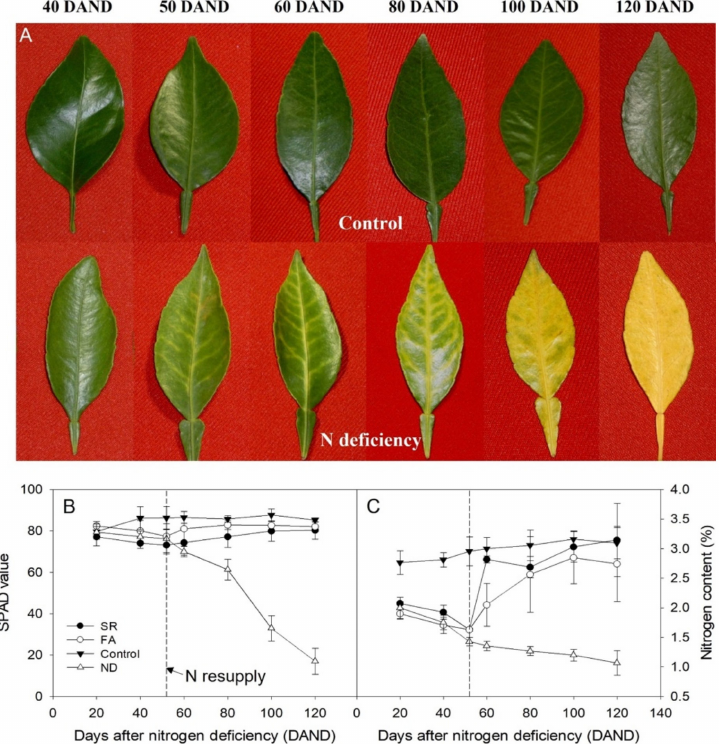
Figure 1. ( A ) Leaf symptoms of N deficiency in ‘Shiranuhi’. ( B ) Changes in SPAD values of the leaves of ‘Shiranuhi’ according to the period of N deficiency and resupply. ( C ) Changes in leaf N content in ‘Shiranuhi’.